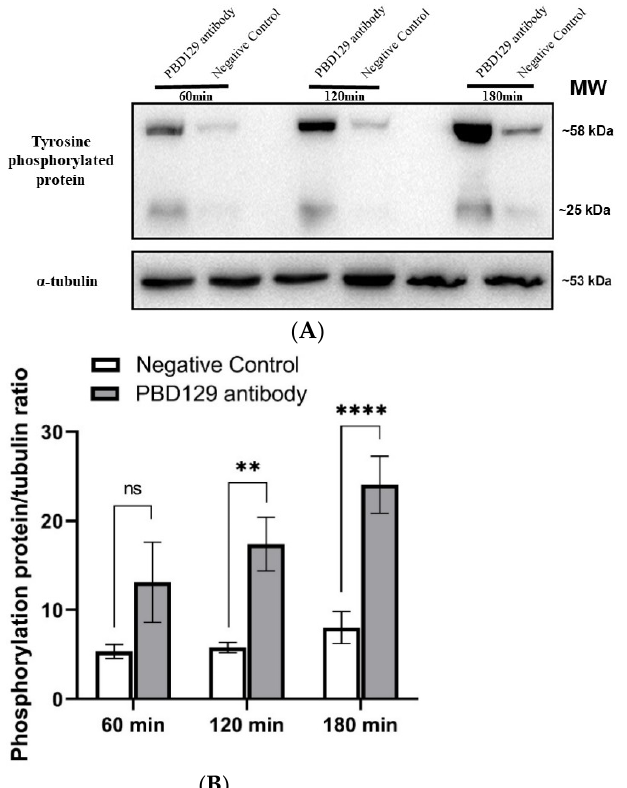
Figure 7. Effects of anti-pBD129 antibody on the rate of acrosome reaction after sperm capacitation in vitro . ( A ) Sperm in different statuses. Sperm samples were fixed with FITC-PNA and Hoechst33342, and scored according to the state of acrosome. a: sperm has not experienced acro- some reaction, and b and c indicate that acrosome reaction has occurred. ( B ) Analysis of sperm acrosome reaction rate before and after capacitation with anti-pBD129 antibody. The mouse IgG as negative control. Data are presented as the mean ± SEM, n = 3. * p < 0.05.